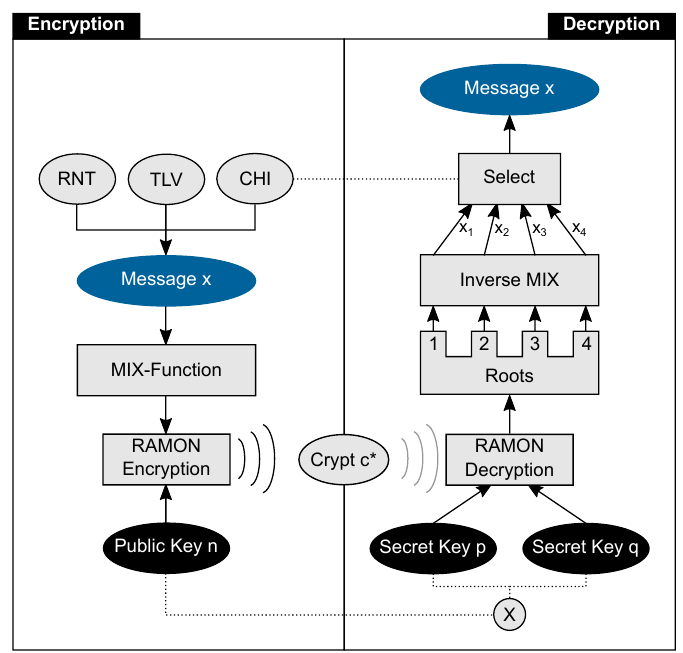
Figure 2. Schematic representation of the RAMON crypto system process. The plain message x is